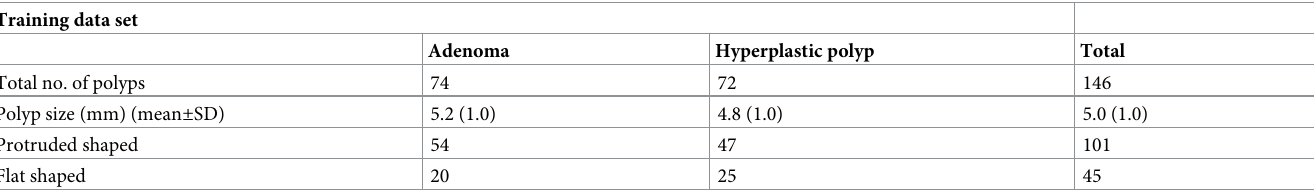
Table 1. Characteristics of the